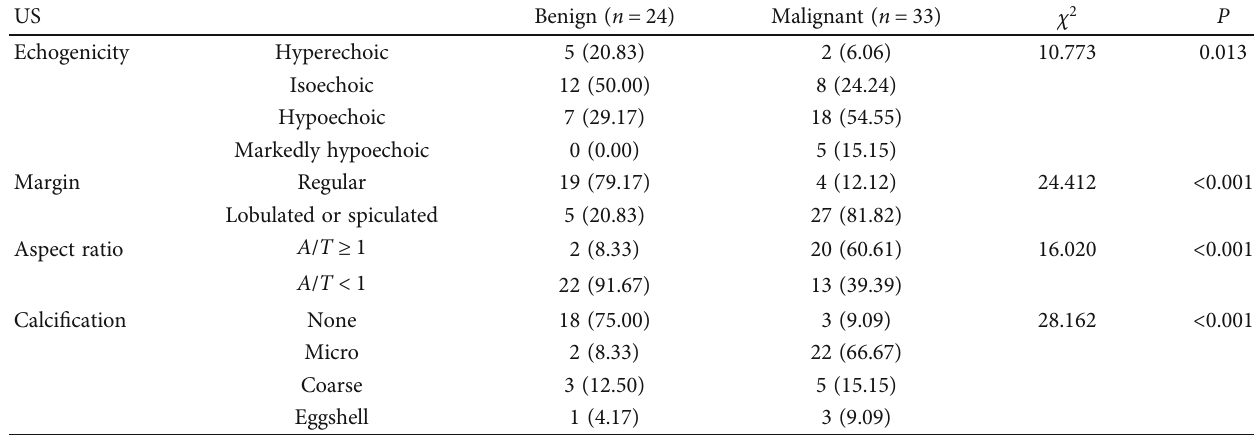
Table 2: Ultrasonographic characteristics of thyroid nodules (US) [ n ð % Þ